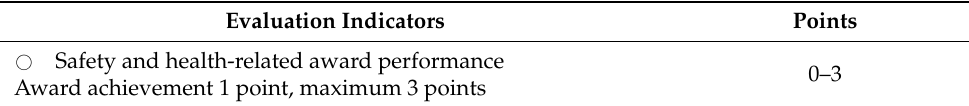
Table 15. Evaluation details for safety and health-related award performance.